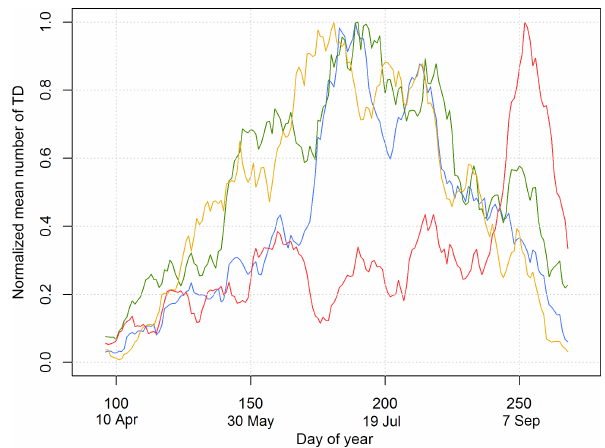
Figure 4. Average diurnal cycle of 10min flash numbers, nor- malized by the respective maximum, for the four regions: Ti- cino (blue), Côte d’Azur (red), Maritime Alps (green), and Bavarian Prealps (yellow); time has been converted to local time (LT).